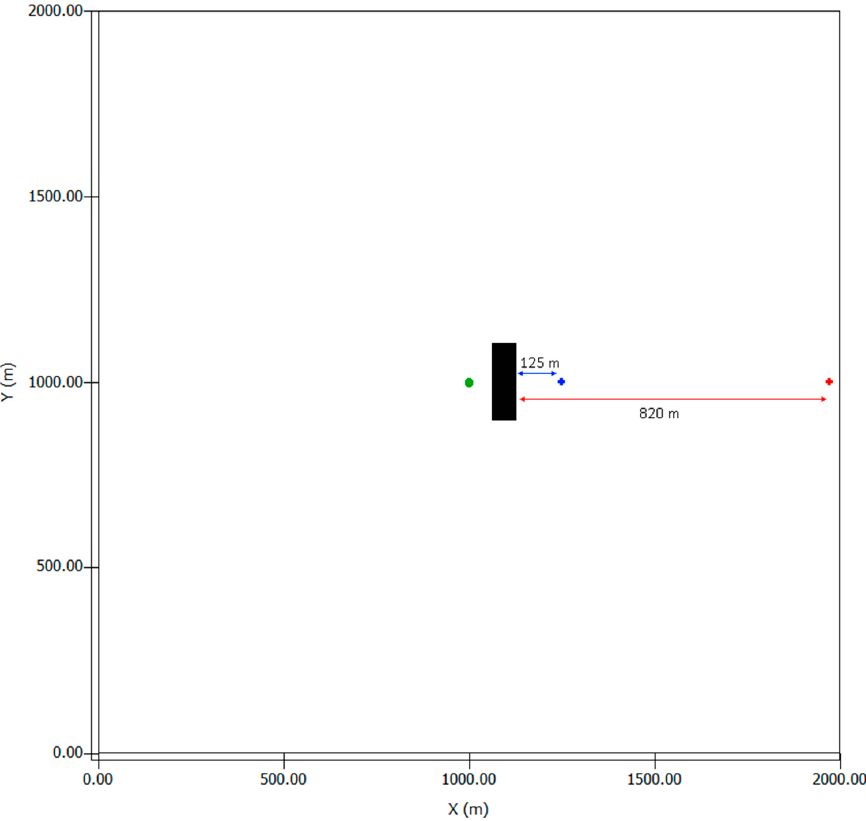
Figure 3. Model area for the simple inhomogeneous simulation featuring a building (black) a tree (green) and two detectors (blue and red). (green) and two detectors (blue and